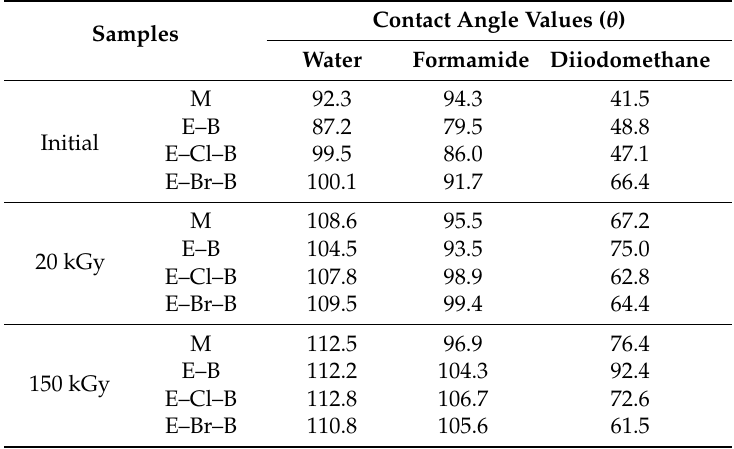
Table 7. Contact angle values ( θ ) between liquid and sample surfaces.